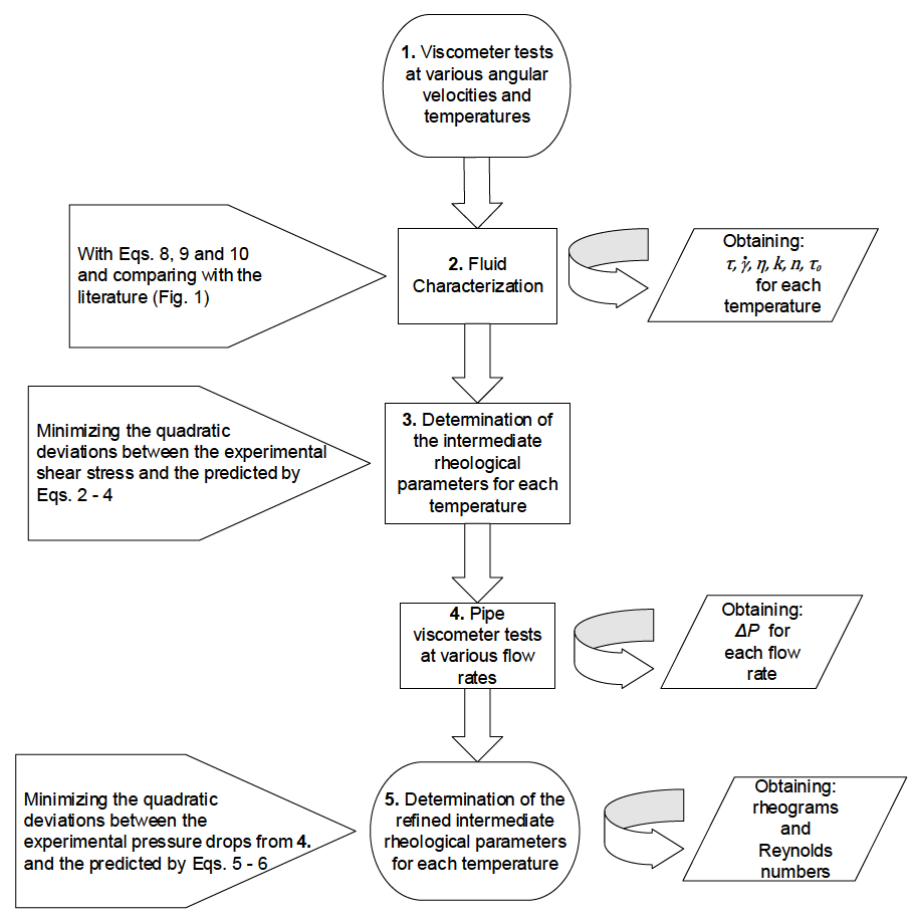
Figure 3: Unified model algorithm and data analysis